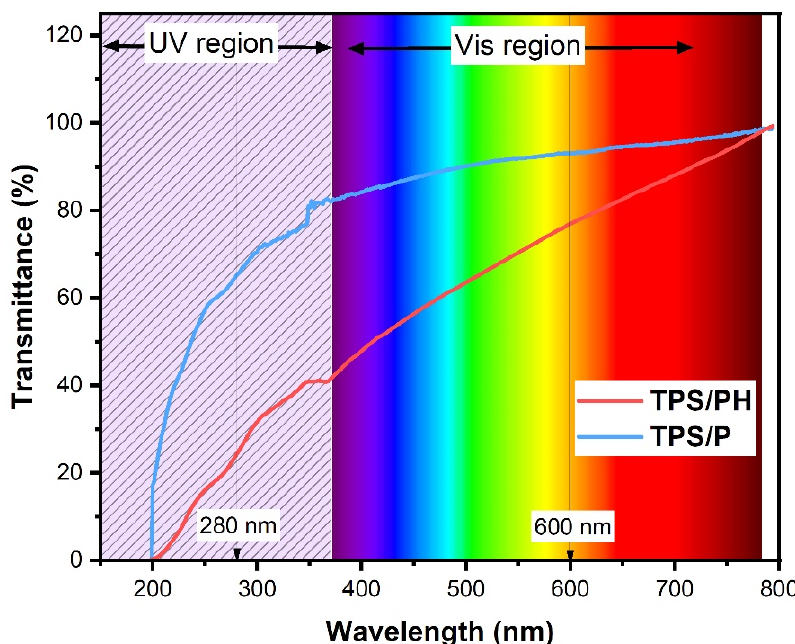
Figure 7. The UV-Vis wavelength transmission curves of TPS/P (blue line) and TPS/PH films (red line). The background shows the colors of light in the UV - visible spectrum.